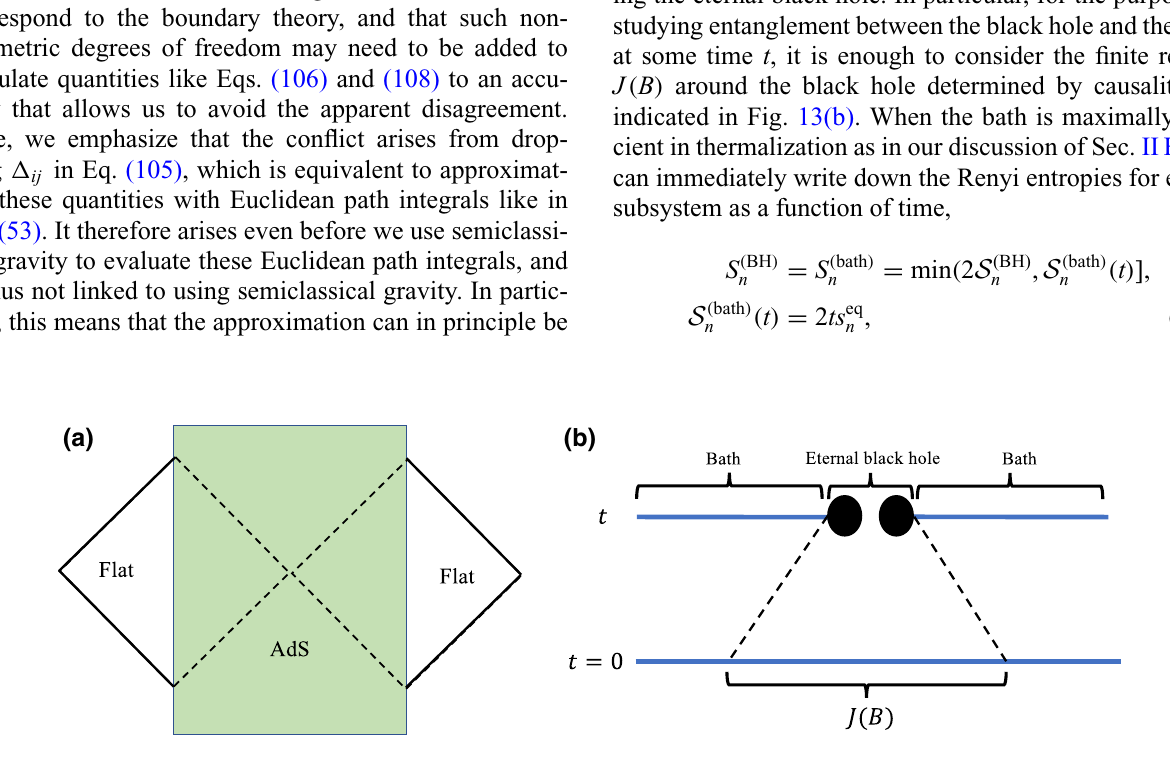
FIG. 13. (a) The Penrose diagram for an eternal black hole in AdS 2 coupled to a bath, the system discussed in Ref. [18]. The shaded region coupled to JT gravity corresponds to the black hole, while the unshaded region with flat Minkowski space corresponds to the bath. (b) A quantum-mechanical system dual to this gravitational system. In this dual theory, the black hole is a (0 + 1)-dimensional system while the bath is (1 + 1) dimensional. At time t , only the part of the time-evolution operator in the region J ( B ) is relevant for finding the entanglement entropies between the black hole and the